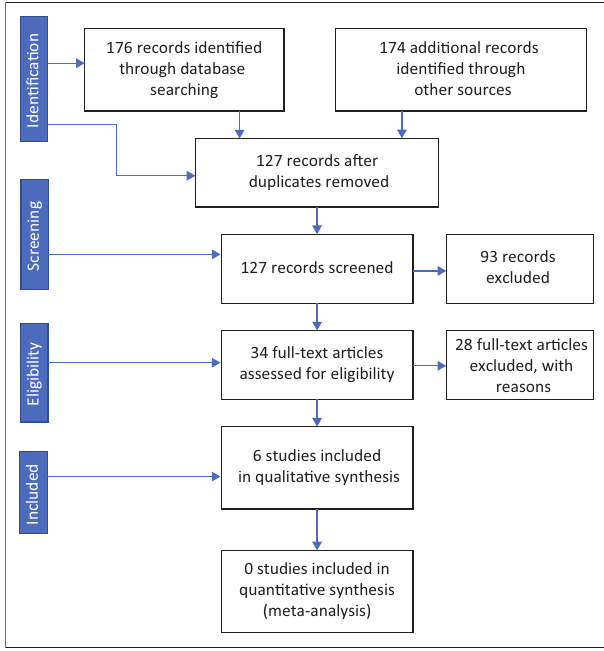
FIGURE 1: Preferred reporting items for systematic reviews and meta-analysis flow diagram for